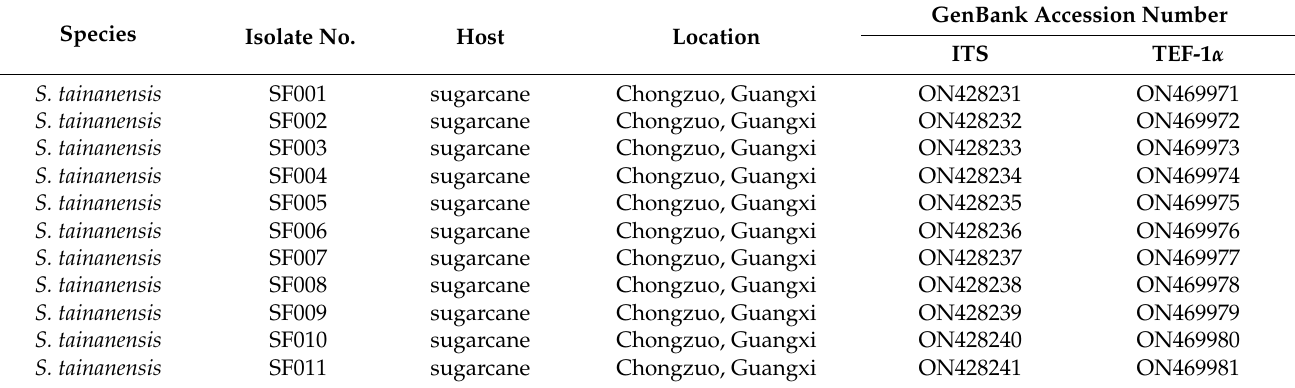
Table 1. Sequence and information of isolates in this